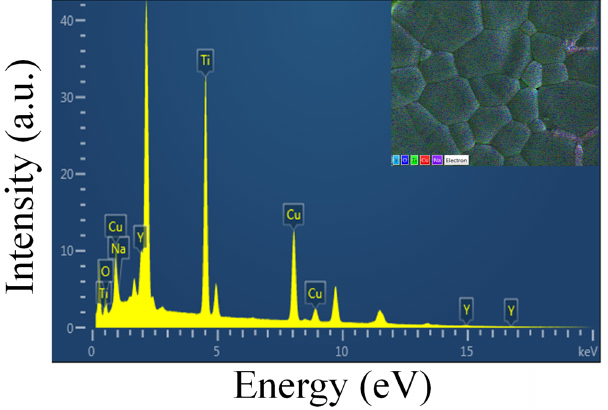
Figure 3. EDS spectrum of Na 1/2 Y 1/2 Cu 3 Ti 4.1 O 12 ceramic sintered at 1070 ◦ C for 15 h.